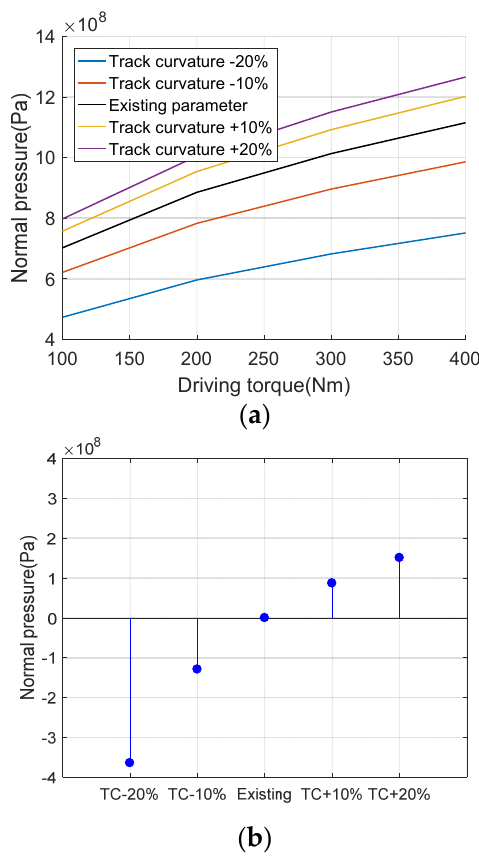
Figure 10. Normal pressure changes with track curvature ( a ) Normal pressure change with respect to driving torque ( b ) Normal pressure change at 400 Nm and 200 rpm.